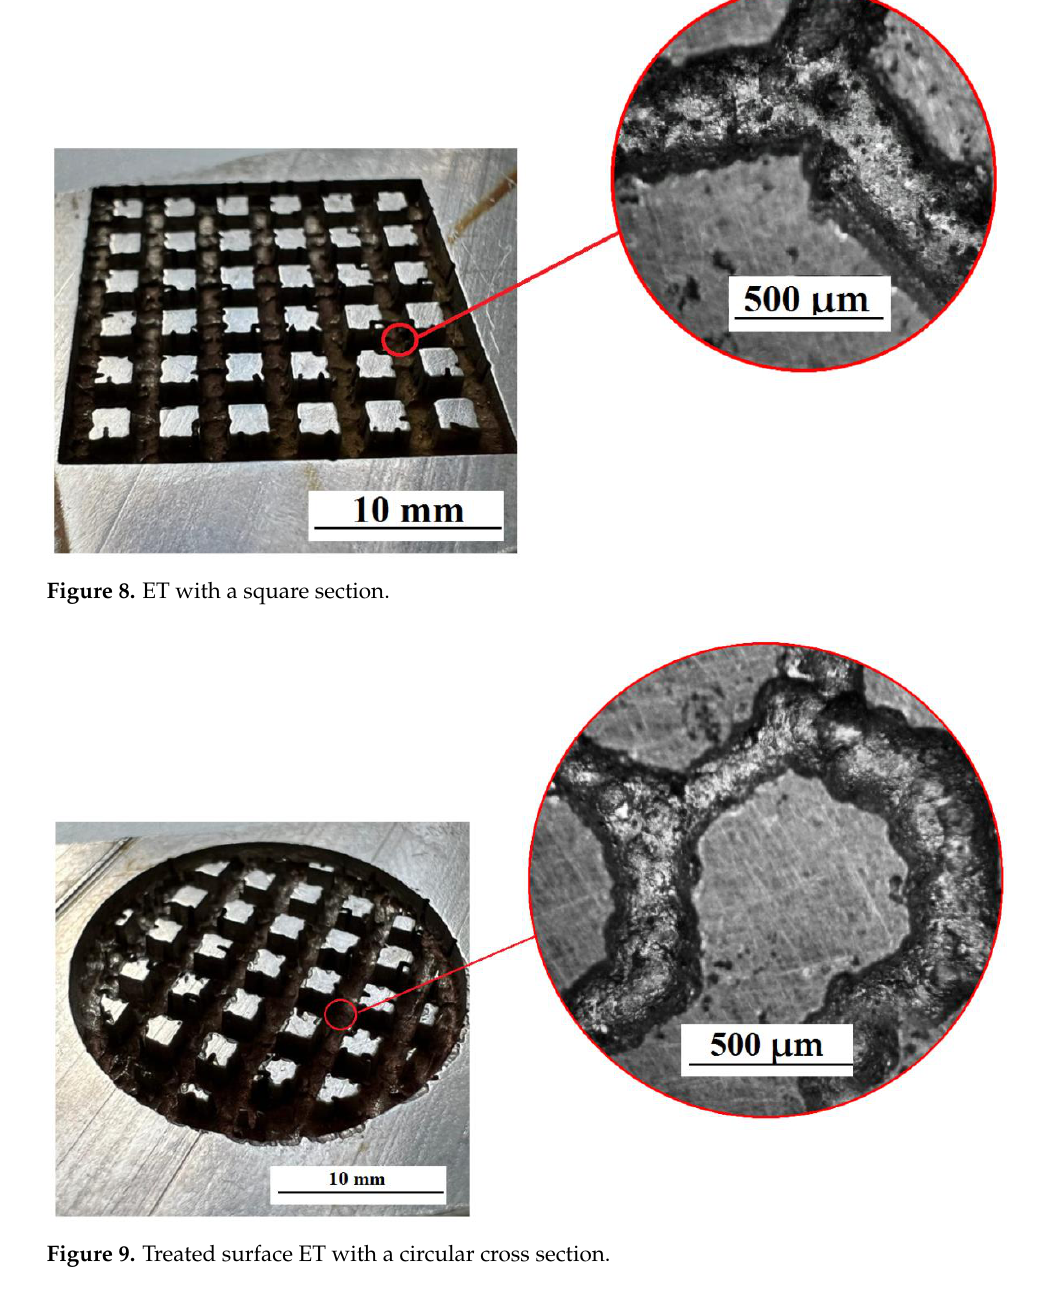
Figure 9. Treated surface ET with a circular cross